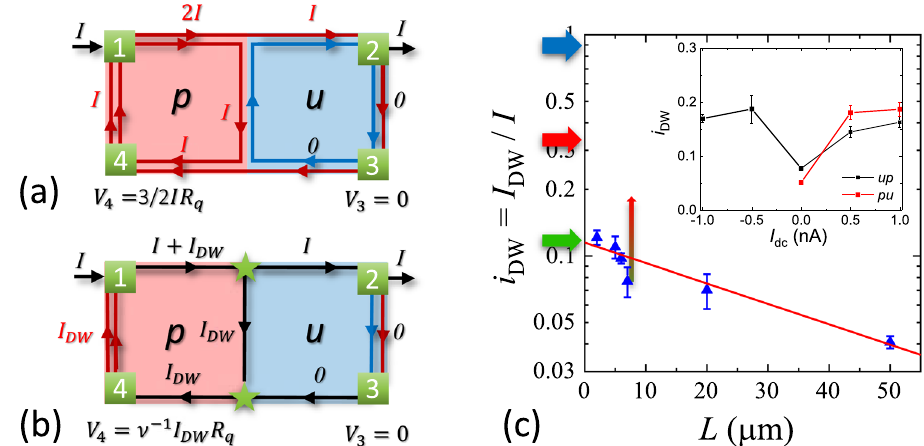
Fig. 2 Conduction of helical domain walls. a A simpli fi ed picture of noninteracting chiral edge modes at ν = 2/3. An inner spin-up edge (red) in p state carries current I while a spin-down edge (blue) in u state carries no current. b Charge conservation and chirality of edge states set the potential V 4 = ν − 1 I DW R q to be proportional to the current I DW diverted via the helical domain wall. c Scaling of the domain wall current i DW = I DW / I with hDWs length L . The values are averaged between up and pu states (within red circles in Fig. 1d), error bars are standard deviations. Red line is a fi t to an exponential decay with the L = 0 value i 0 ¼ 0 : 115 and the decay length L 0 = 47 μ m. Arrows indicate i 0 values expected for naive noninteracting edge model (blue) and Luttinger liquid model in the DW DW absence of spin- fl ip (red) and at spin- fl ip probability r = 3/4 (green), see text for details. Vertical arrow marks i DW shift when I dc = 1nA is applied. In the inset i μ m hDW for up and pu gates con fi guration right after the dc current is applied and before a DW dependence on large external dc current is plotted for 7 measurable build-up of nuclear